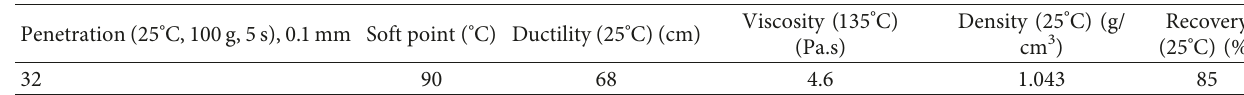
Table 1: The main technical indicators of SBS-modified asphalt.